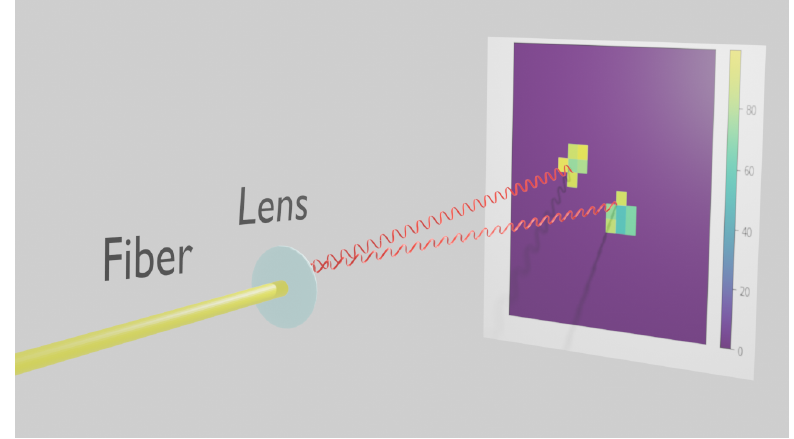
Figure 2. Two photons coming out of a single-mode fiber, focused on to the fast pixel camera and registered